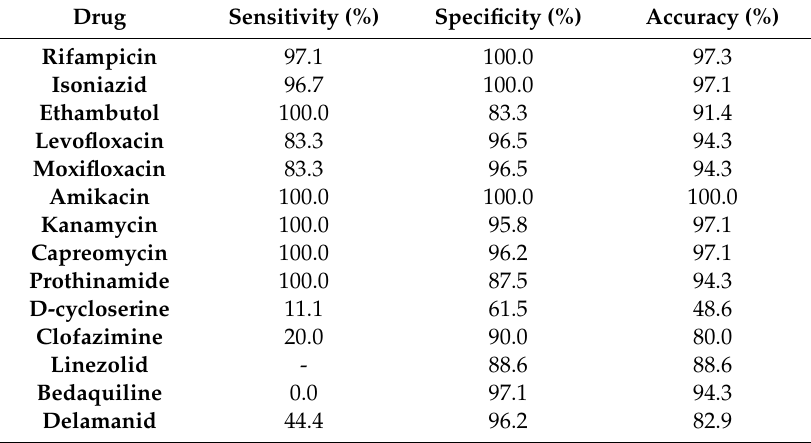
Table 6. Sensitivity, specificity, and overall accuracy of whole genome sequencing compared to the phenotypic drug susceptibility